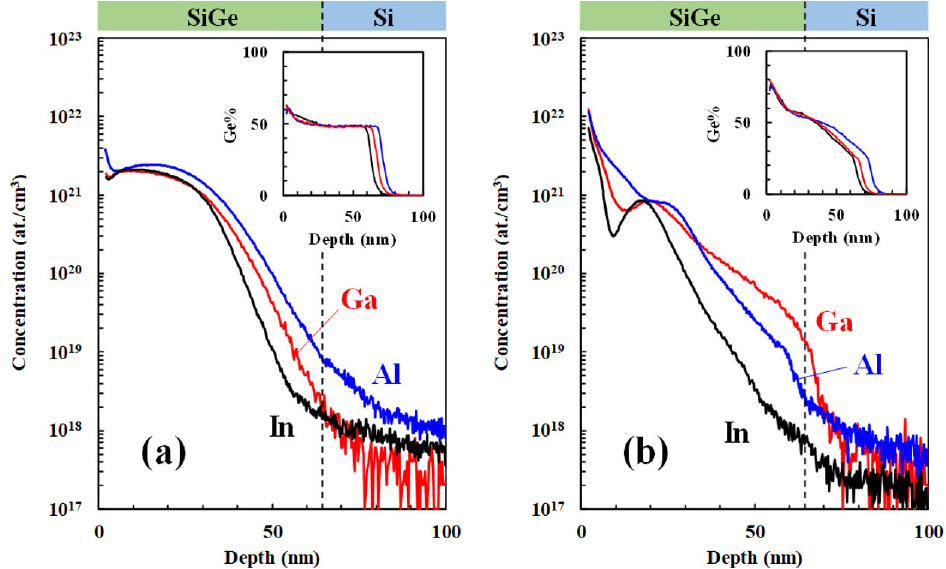
Figure 6. Secondary ion mass spectrometry (SIMS) profiles of Ga, In, and Al taken in the ( a ) as- implanted and ( b ) ns UV-LA-induced full SiGe epilayer melt samples. Reprinted with permission from Ref. [41]. 2019, The Japan Society of Applied